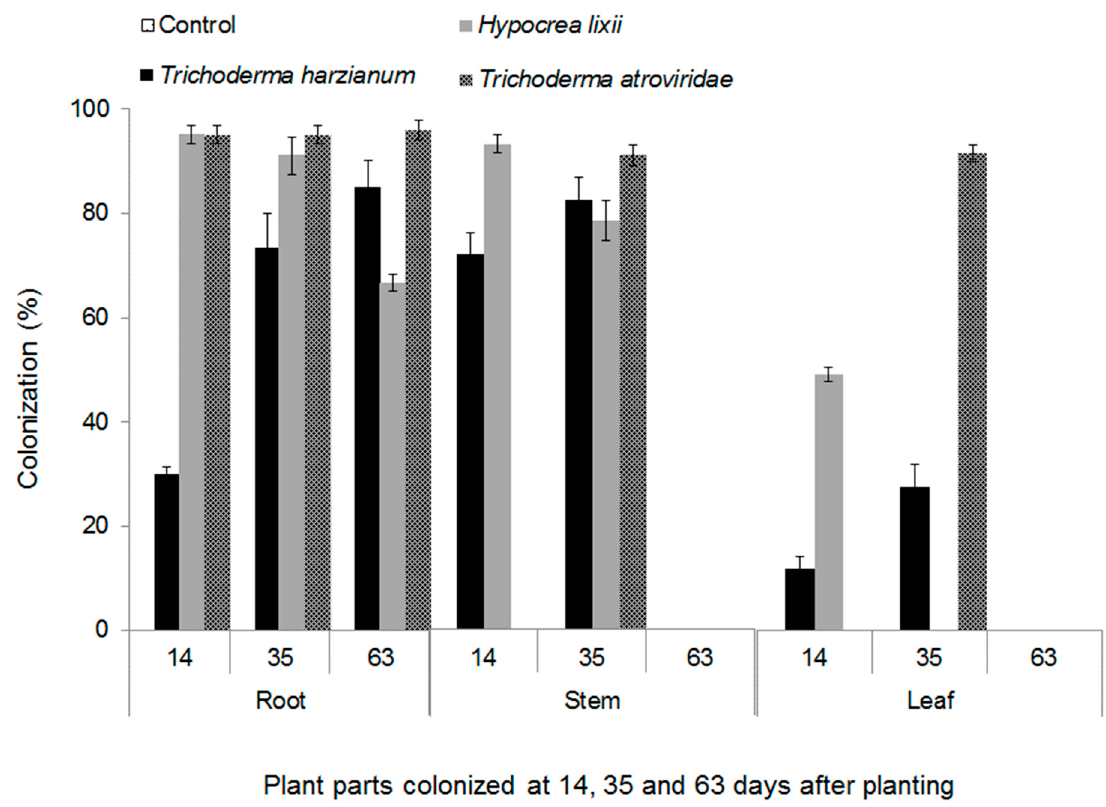
Figure 1. Endophytic colonization (%) of root, stem and leaf sections of maize plants by Trichoderma harzianum (F2L4), Hypocrea lixii (F3ST1) and Trichoderma atroviride (F5S21) at 14, 35 and 63 days after planting. The bars represent means ± SE.